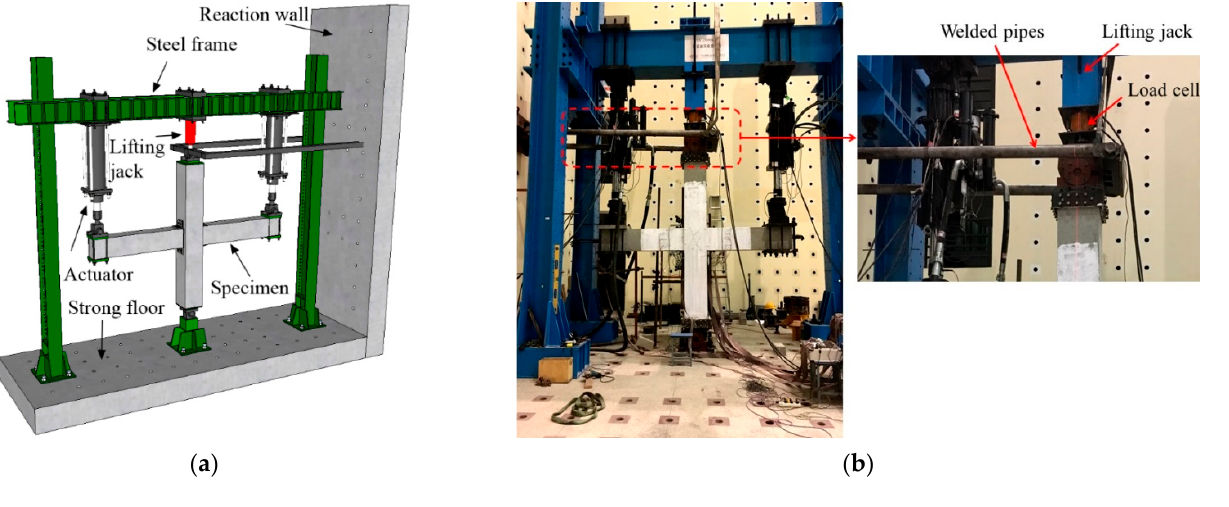
Figure 7. Cyclic displacement-controlled loading history. 3. Experimental Results 3.1. Crack Pattern and Failure Mode The crack patterns and failure modes of these specimens are illustrated in Figures 8 and 9, respectively. For the PC connection, a flexural crack 0.02 mm in width developed at the intersection of the beam and column regions (i.e., the potential plastic hinge), with the displacement of vertical actuators reaching 3 mm. When the yielding of the longitudi- nal rebar initially appeared, with a displacement of up to 9 mm (i.e., Δ y = 9 mm), several flexural cracks 0.15 mm in width propagated through the plastic hinge (Figure 8a). Then, a few diagonal cracks appeared in the connection core zone, with the vertical displace- ment reaching 3 Δ y , and they further propagated along the diagonal directions. When the